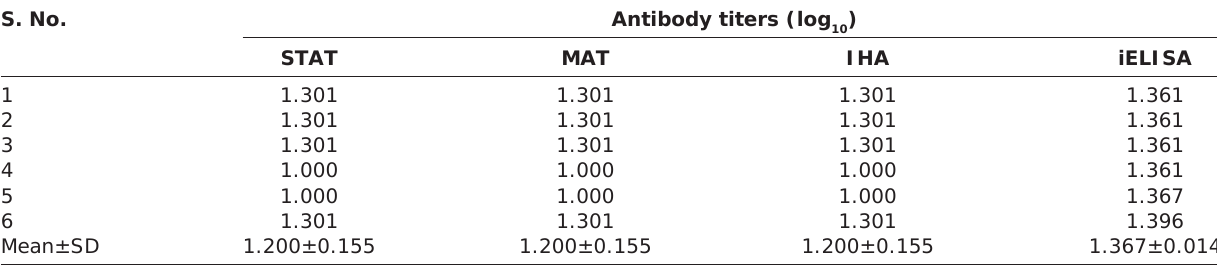
Table-3: Antibody titers of healthy cattle vaccinated with B. abortus strain 19 vaccine. S.